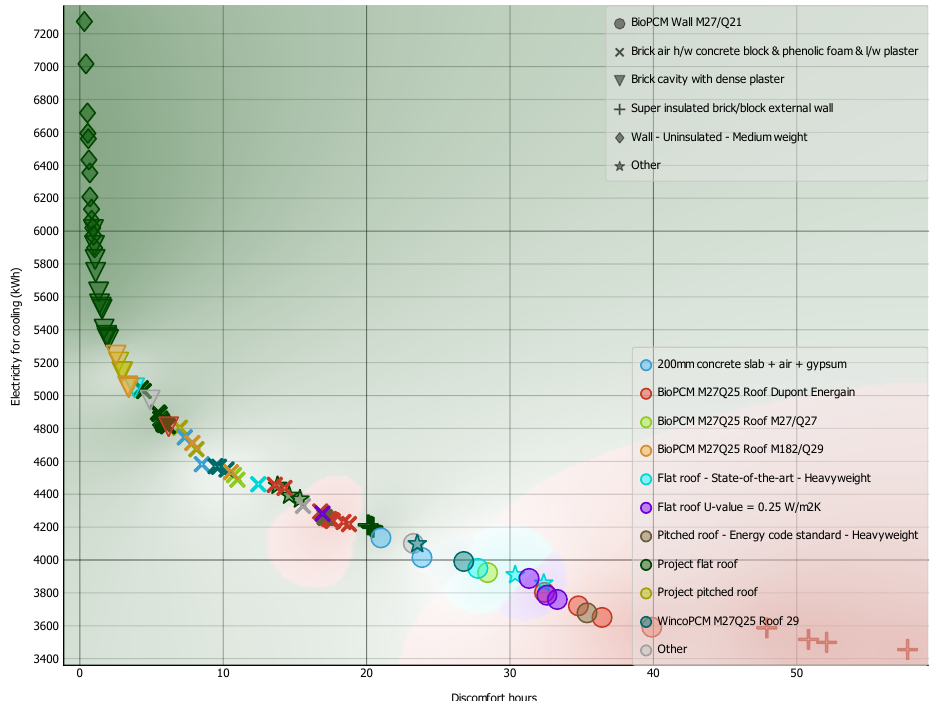
Figure 5. Optimization analysis result at Pareto’s front for the H100 operating in AC